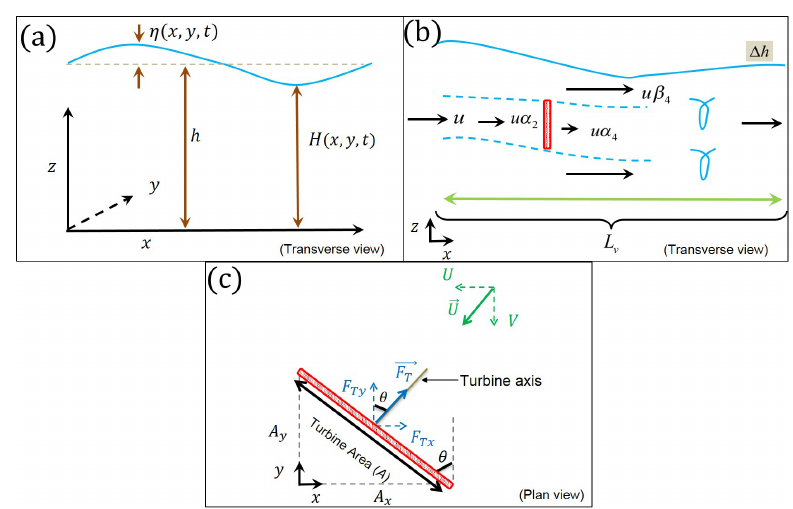
Figure 2. Sketches of the 2D shallow waters model ( a ), the tidal-stream power extraction with an actuator disc in open channel flows model ( b ), and turbine’s thrust force (cid:126) F T exerted on the incident tidal-stream ( c ).